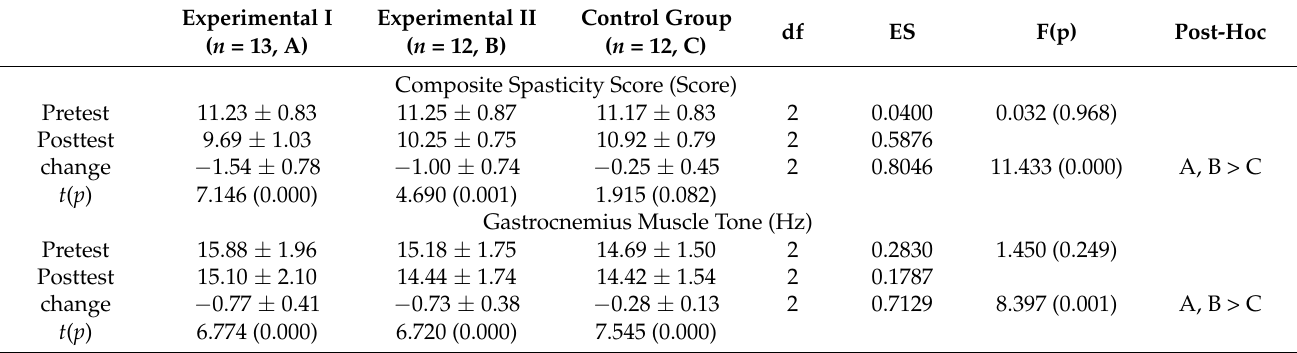
Table 4. Comparison of CSS and GMT among the three groups.